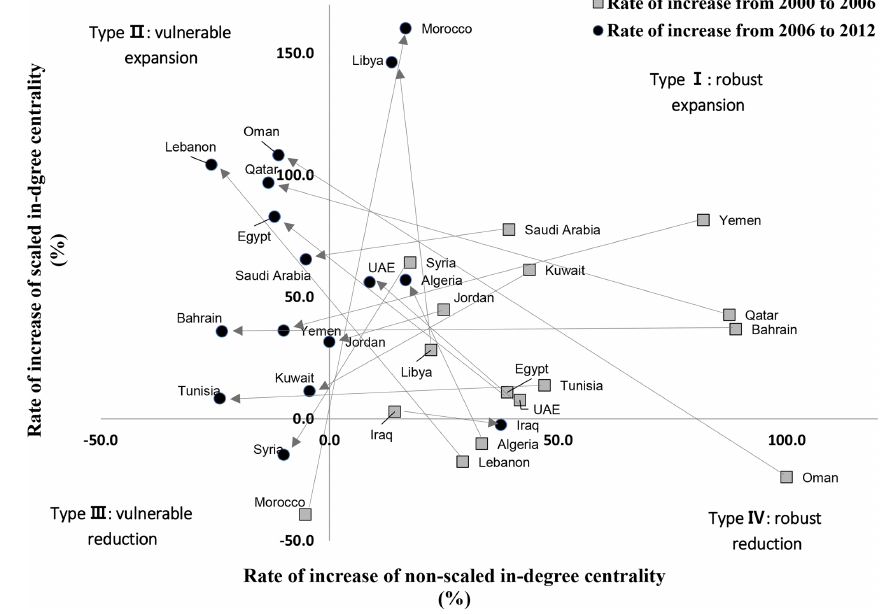
Figure 6. Country types in the MENA region according to the changes in nonscaled and scaled in-degree centralities.